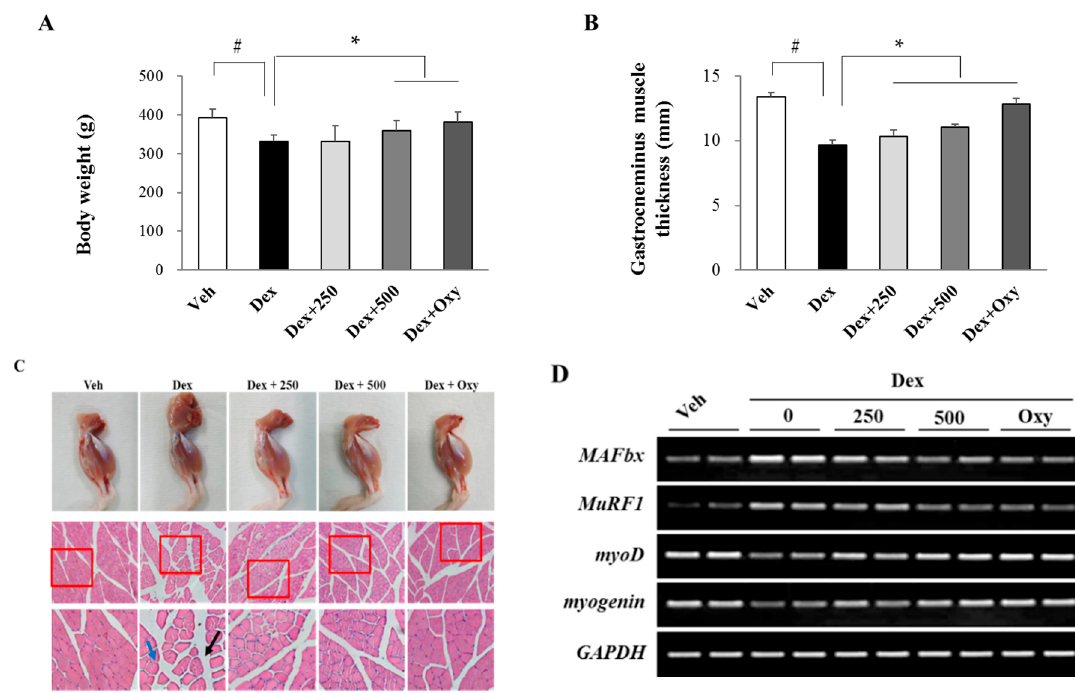
Figure 1. Anti-myopathy activity of ethanol extract of Angelica keiskei in dexamethasone-induced muscle atrophied rats. Effects of ethanol extract of AK (EAK) (250 and 500 mg/kg) on body weight ( A ) and gastrocnemius muscle thickness ( B ). ( C ) Gross appearance and histopathological images of the hind limb of rats. Black arrow indicates the perimysium and blue arrow indicates the endomysium. ( D ) Changes in gastrocnemius muscle mRNA expression were measured by reverse transcription polymerase chain reaction (RT-PCR). Oxymetholone (Oxy) was used as a positive control (50 mg/kg). Data are expressed as mean + SD (n = 6). # p < 0.005 vs . vehicle control rat (Veh); * p < 0.005 vs . dexamethasone treated rat (Dex).